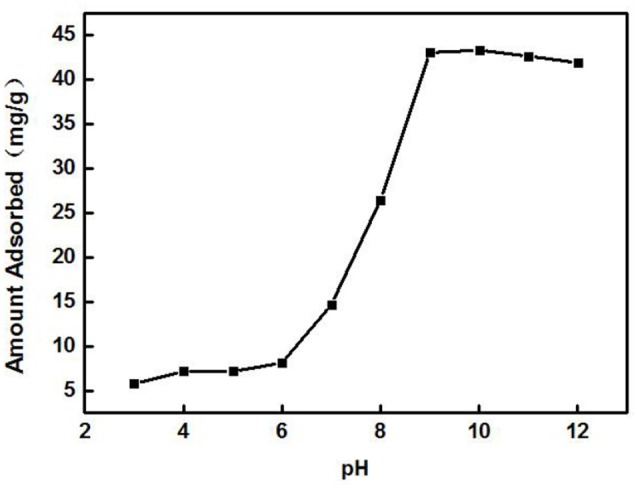
Effect of pH on the adsorption of Cd2+ by ZSR-P.